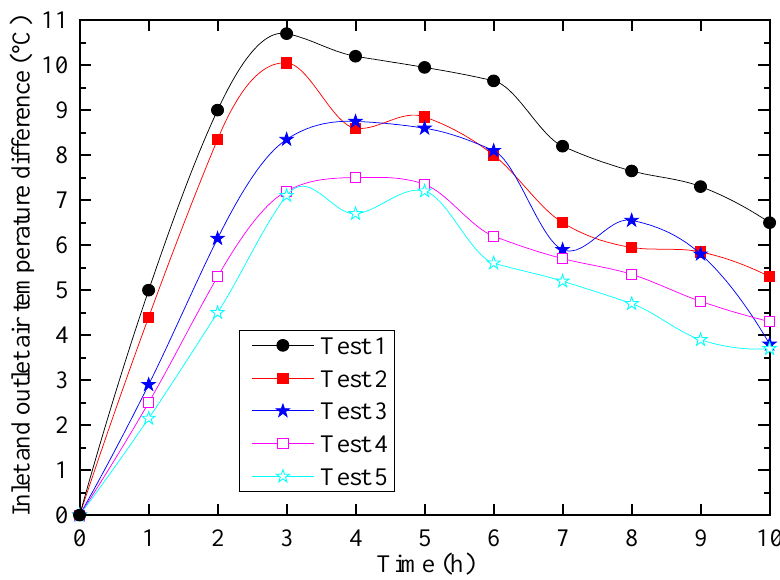
Figure 8. Variation of the temperature difference between the inlet and outlet air with time. Table 3. The temperature difference of the inlet and outlet air for five tests ( ◦ C).